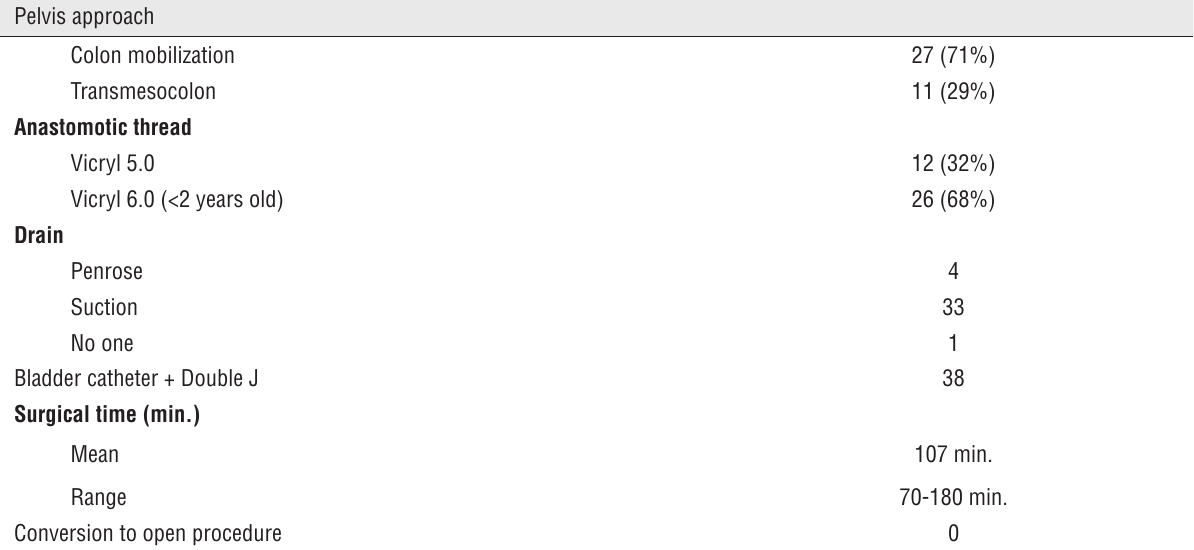
Table 1 - Laparoscopic Pyeloplasty - surgical details.